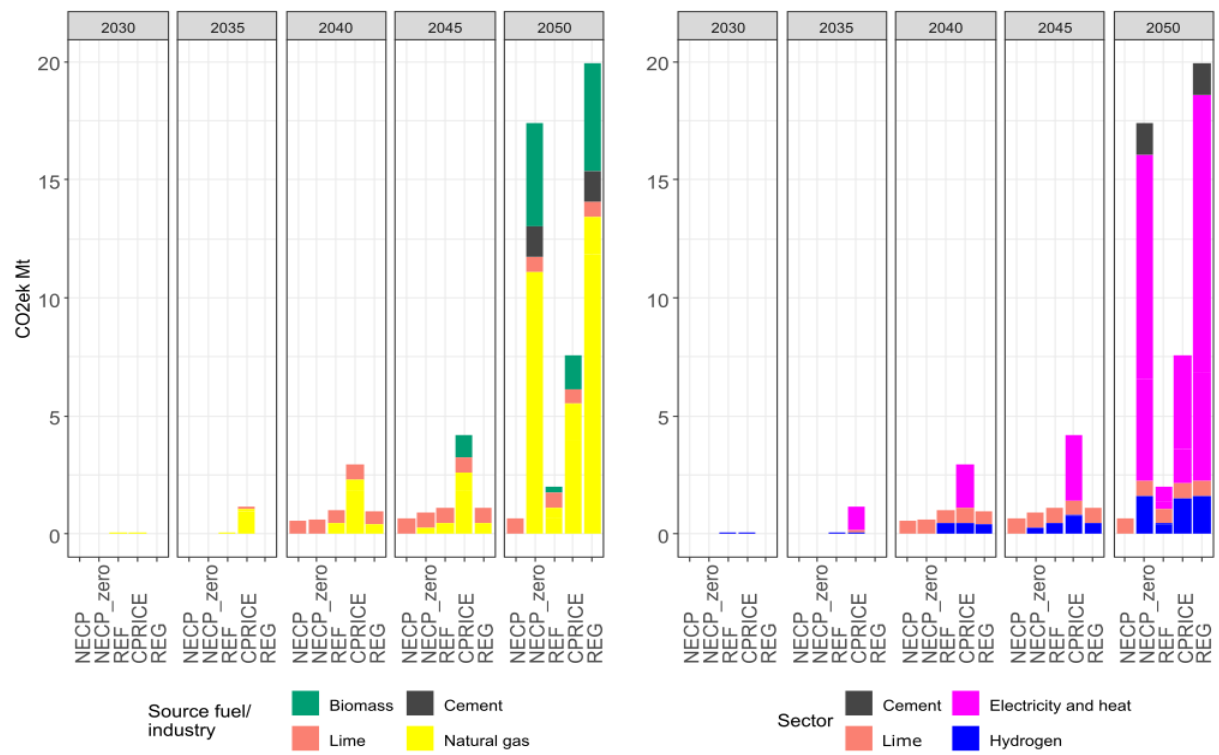
Figure 7. Emissions of GHG by sector (without LULUCF).